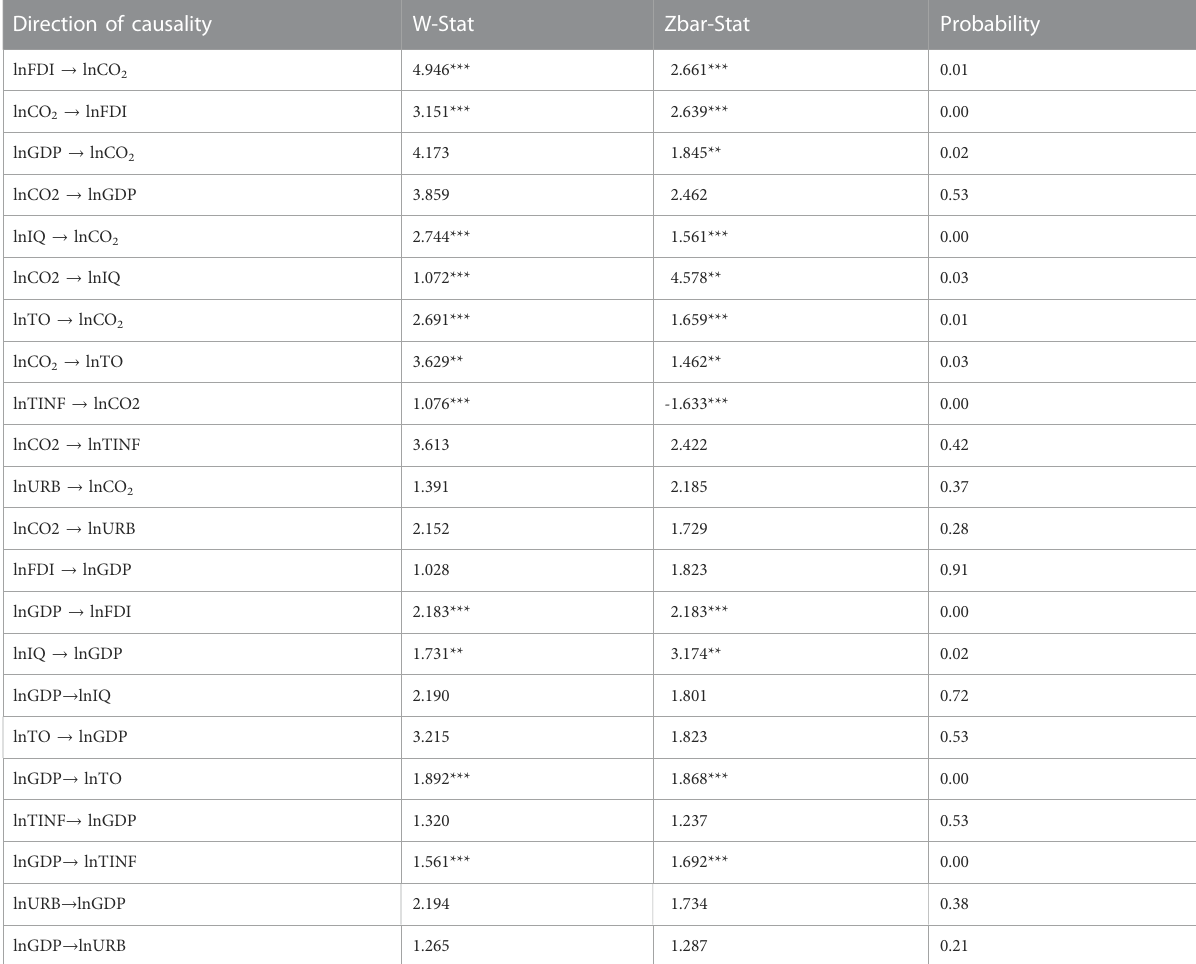
TABLE 8 Results of Dumitrescu and Hurlin pairwise causal relationships between variables in the proposed model. Direction of